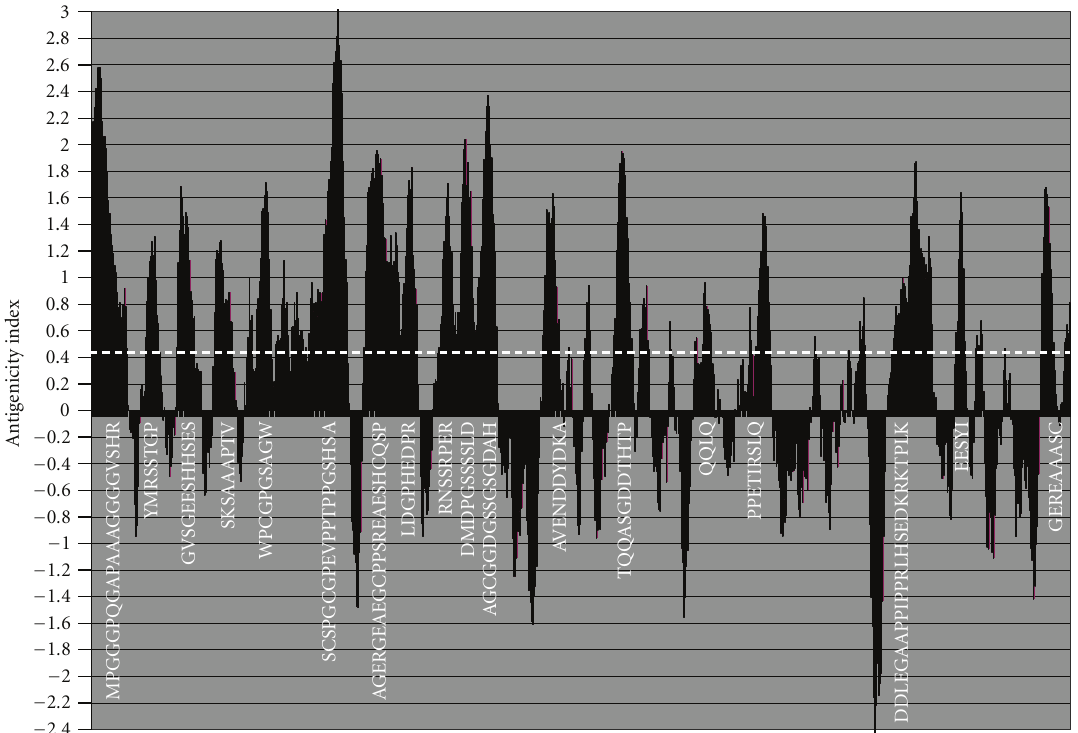
Figure 4: The antigenicity (B-cell epitope prediction) of DISC1: the amino acid sequences with an index of > 0.35 are considered as epitopes. A value of 0.8 was chosen to define highly antigenic regions as seen in Figure 2. The amino acid sequences of these highly antigenic regions are